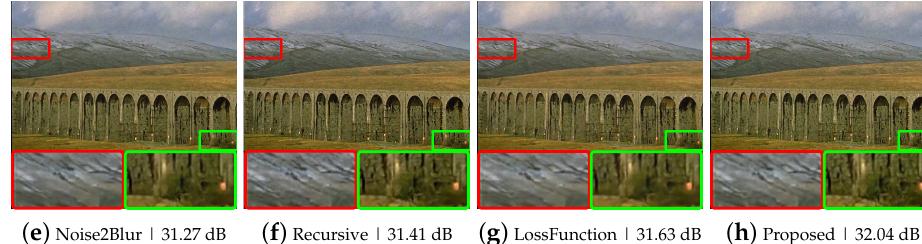
Figure 5. Example images of Gaussian denoising: ( a ) a clean image; ( b ) a Gaussian noisy image; ( c – h ) example images of Gaussian denoising using various noise removal methods.